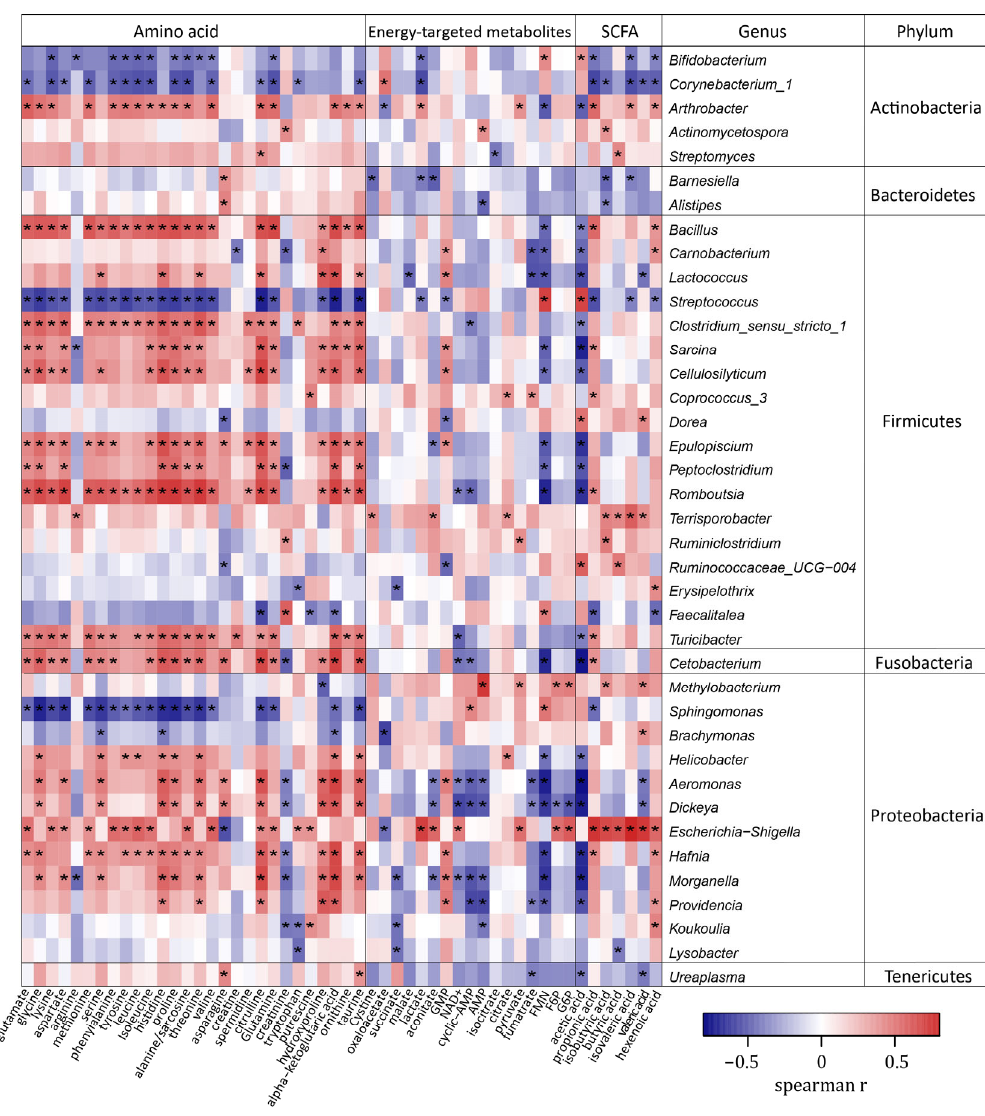
Figure 4. Heatmap of the correlation between gut microbial genera and fecal metabolites in giant pandas. The red and blue squares represent positive and negative correlations between metabolites and gut microbiota, respectively. The * symbols represent p < 0.05, ** symbols represent p < 0.01.